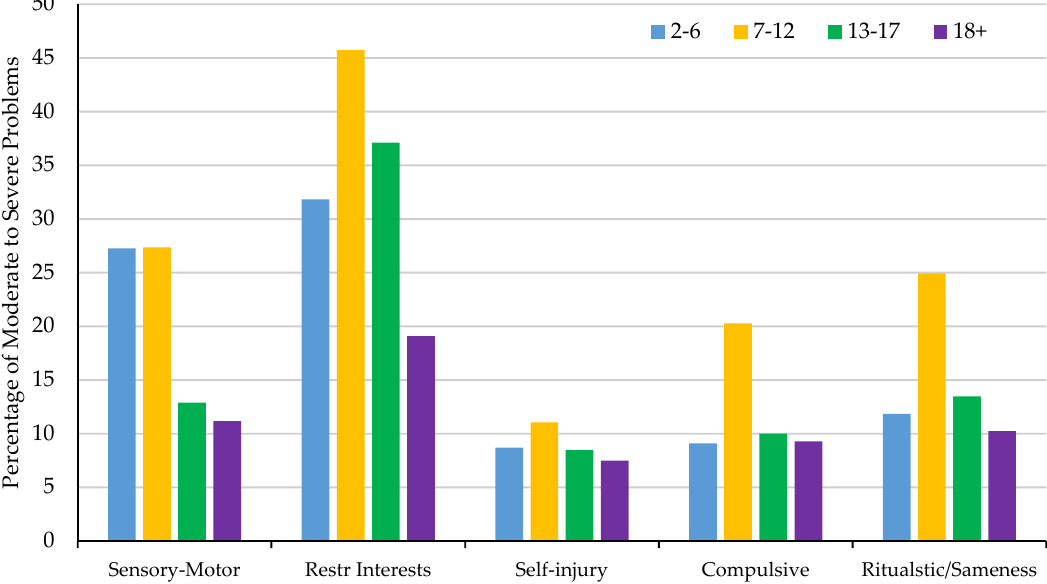
Figure 4. The average percentage of caregivers reporting behaviors to be a moderate to severe problem (a score of 2 or 3) between 2–6, 7–12, 13–17, and 18+ years of age for the RBS-R subscales.